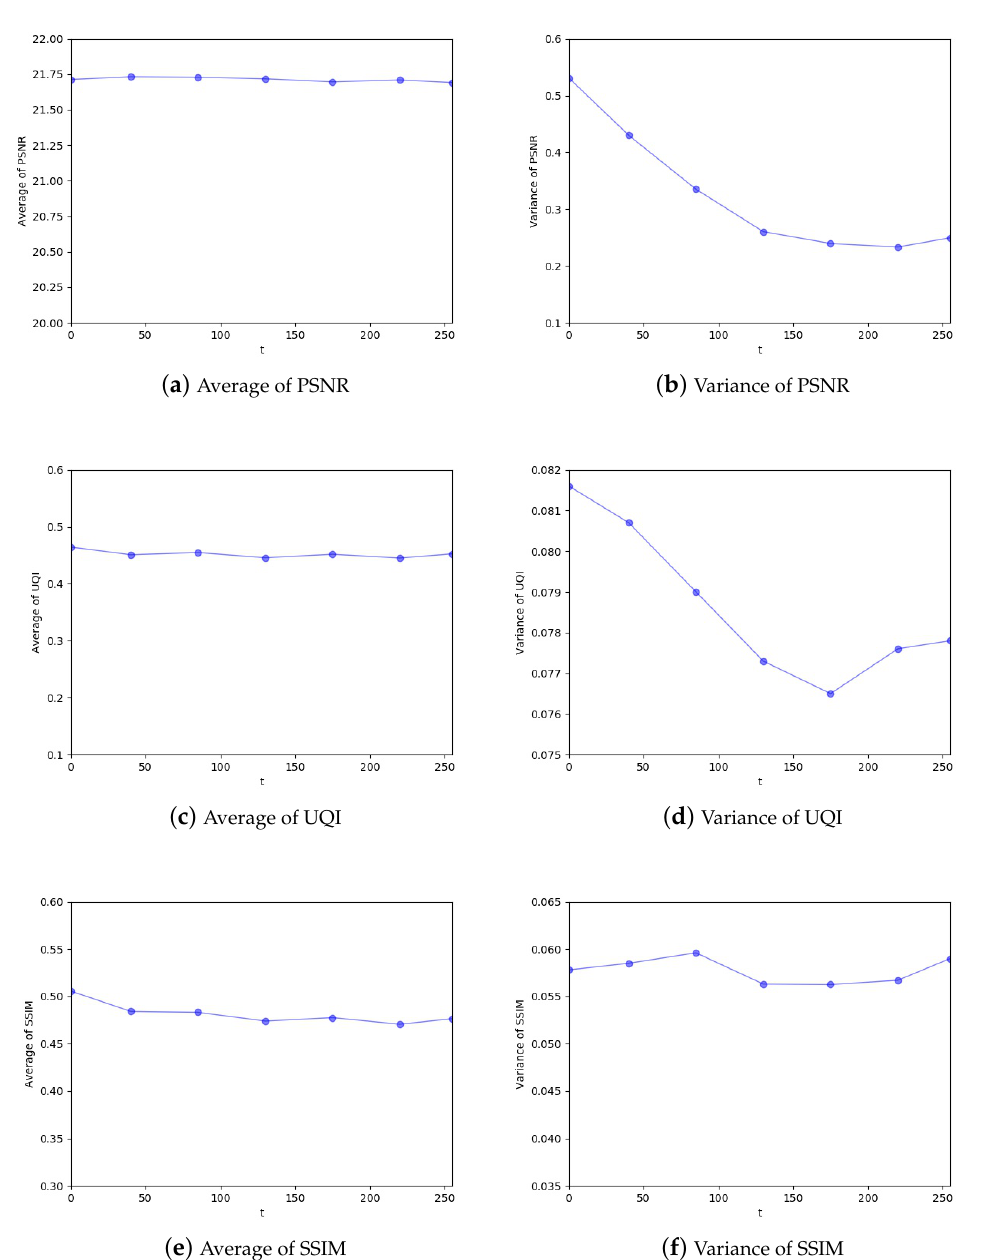
Figure 8. Metric results with different t values for (2,2) threshold; ( a , b ) average and variance of PSNR with different t values; ( c , d ) average and variance of UQI with different t values; ( e , f ) average and variance of SSIM with different t